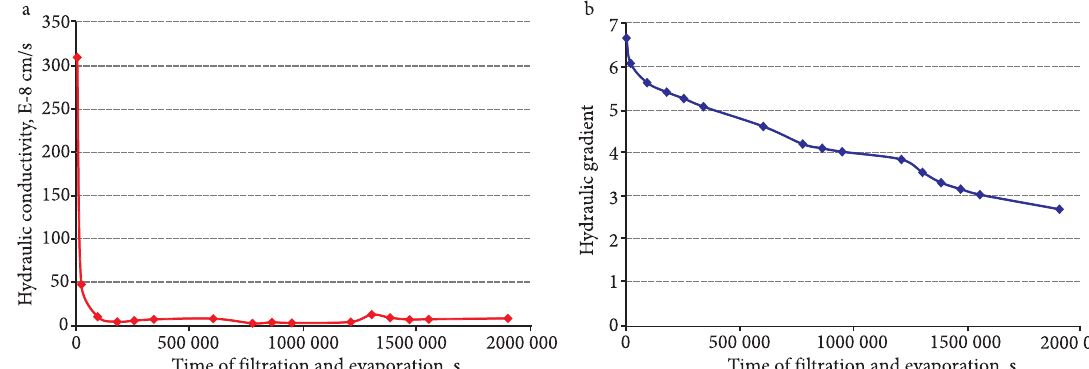
Fig. 6. Results of simultaneous filtration and evaporation experiment (the constant volume air chamber is formed above the sample surface): a – hydraulic conductivity dependence on time; b – hydraulic gradient dependence on